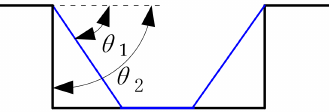
Figure 12. Traditional multi-stage incremental forming strategy.